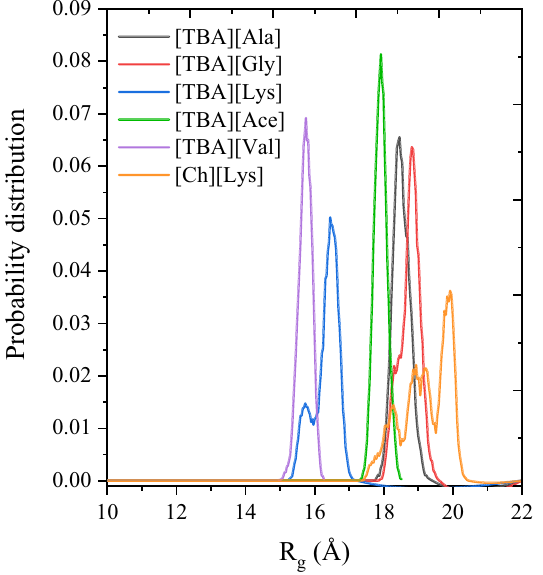
Figure 8. The probability distribution of R g for the lignin polymer in ionic